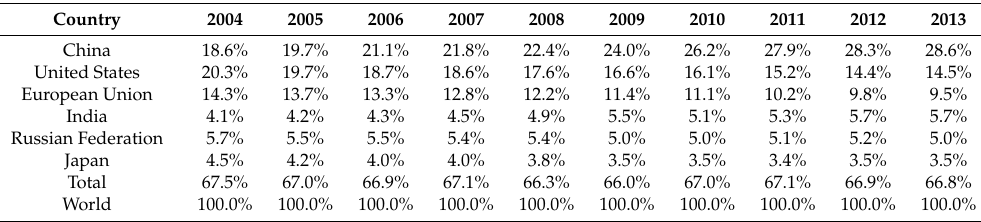
Table 7. Proportion of carbon emission in main countries and regions.